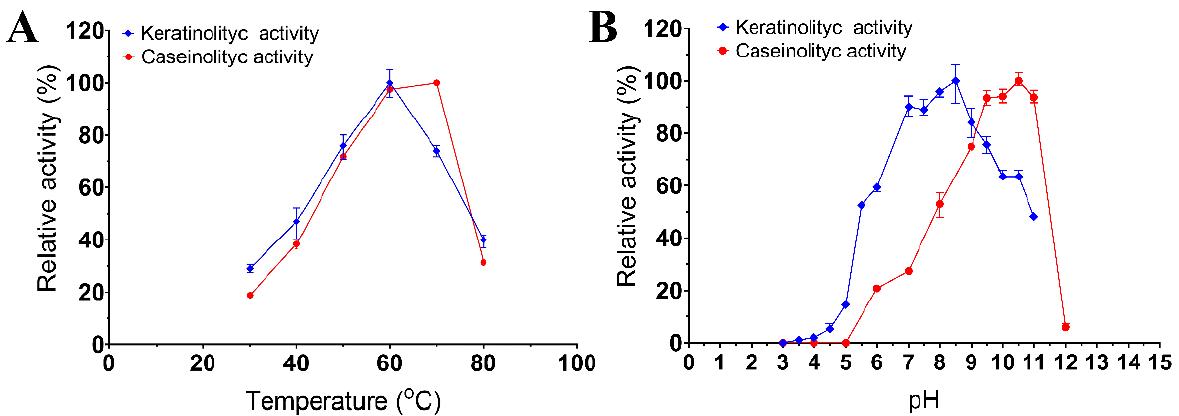
Figure 3. Effects of temperature ( A ) and pH ( B ) on keratinolytic and caseinolytic activities. Values shown in ( A , B ) (mean ± standard deviation [SD]) are representative data obtained in triplicate assays of the enzymatic extract from Bacillus sp. A5.3.